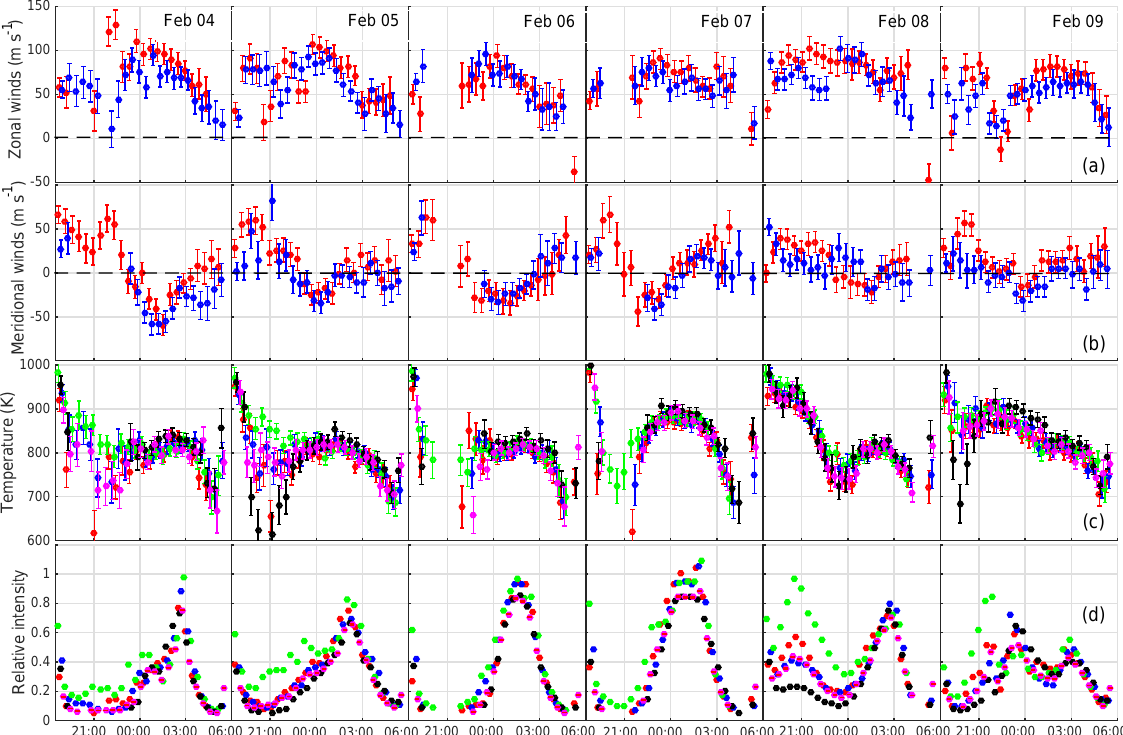
Figure 2. Sequential nights (4 to 9 February 2016) of zonal wind measurements (top row) for west (red dots) and east (blue dots) directions, meridional wind measurements (second row) for south (red dots) and north (blue dots) directions, and temperature (third row) and relative intensity (bottom row) from all viewing directions (east, west, north, south and zenith, in red, blue, green, black and magenta,